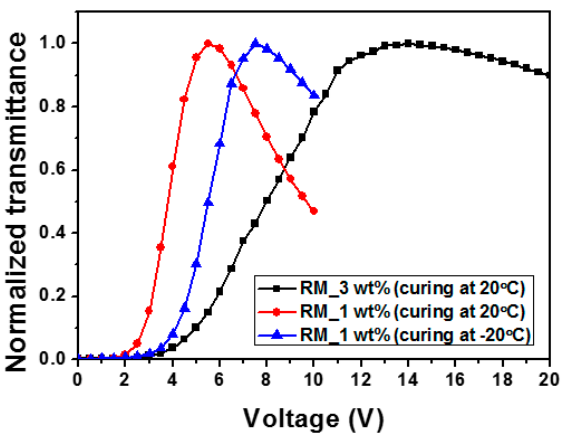
Figure 3. ( a ) Threshold and operating voltages and ( b ) transmittance in the dark state of polymer- stabilized IPS cells with RM concentrations of 1 and 3 wt% as functions of the curing temperature.